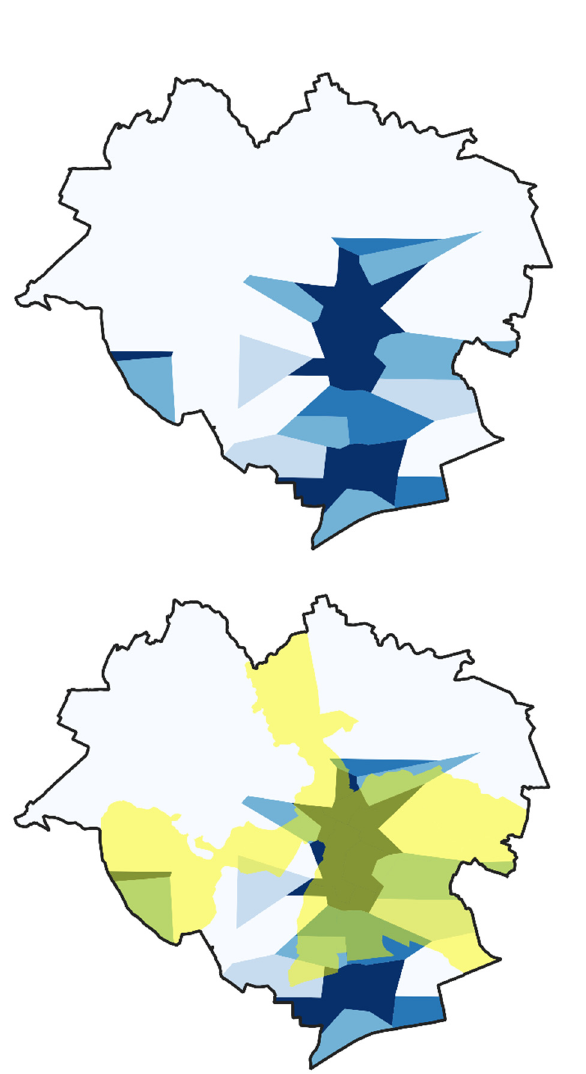
Figure 7. Comparison of the density of pharmacies (blue) and the location of districts inhabited by most of the surveyed senior citizens (yellow) in Olsztyn. Source: own elaboration.